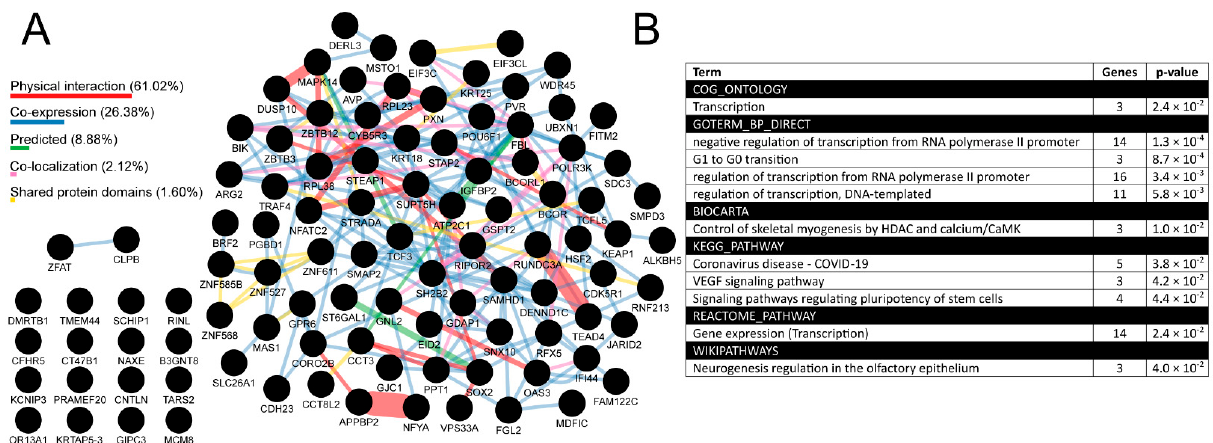
Figure 10. Summary of the most valuable data from between-tumors correlation analysis in the form of interconnectivity ( A ) and gene ontology ( B ). Percentage contribution of a few aspects (marked in various colors) that constitute the interconnectivity of the network is provided. Analysis per- formed via cBioPortal, GEPIA2, CorrelationAnalyzeR, and UALCAN, visualized using GeneMania and